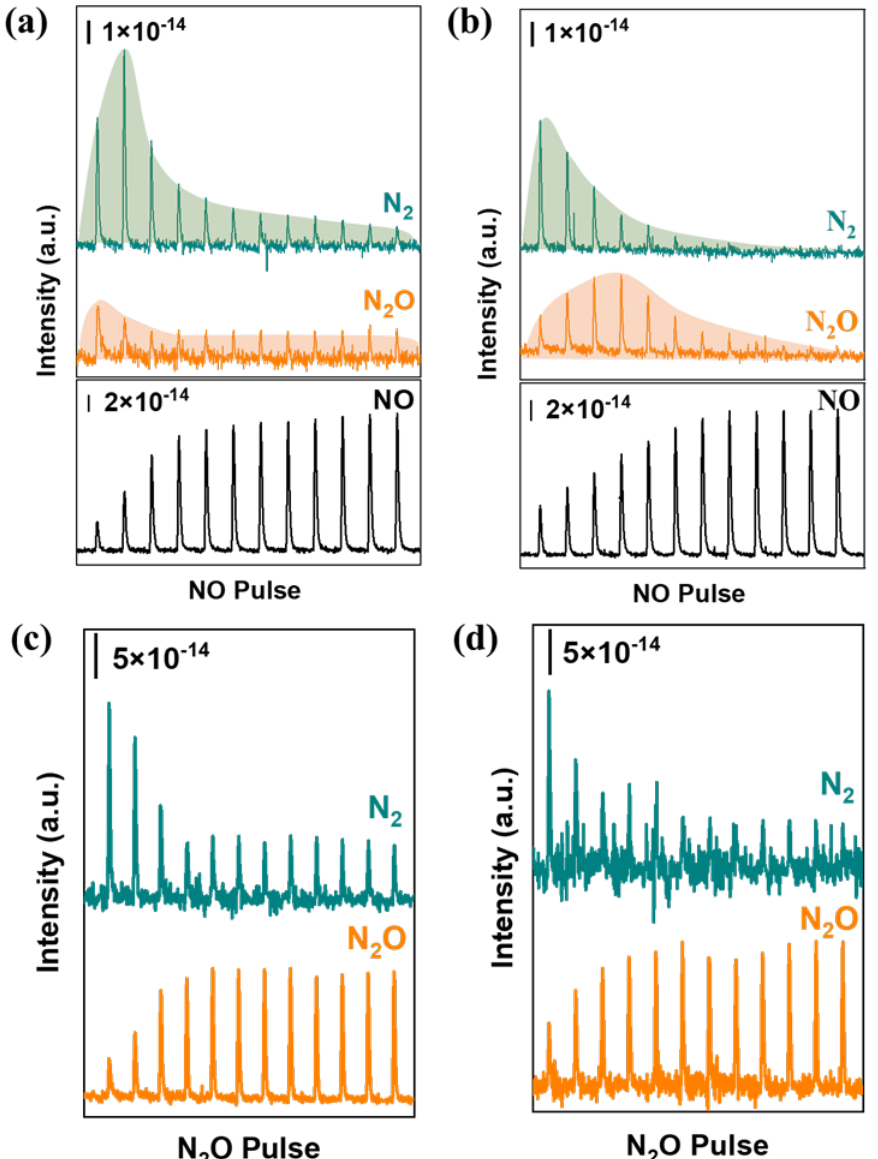
Figure 7. Monitoring of NO consumption and product formation during NO pulses by the mass spectrometer at 200 ◦ C over ( a ) FSP-CuCe and ( b ) CP-CuCe catalysts. Monitoring of N 2 O consump- tion and N 2 formation during N 2 O pulses by the mass spectrometer at 200 ◦ C over ( c ) FSP-CuCe and ( d ) CP-CuCe catalysts. The samples were firstly reduced by CO at 200 ◦ C, then 5%NO/He or 5%N 2 O/He was pulsed into the reactor.